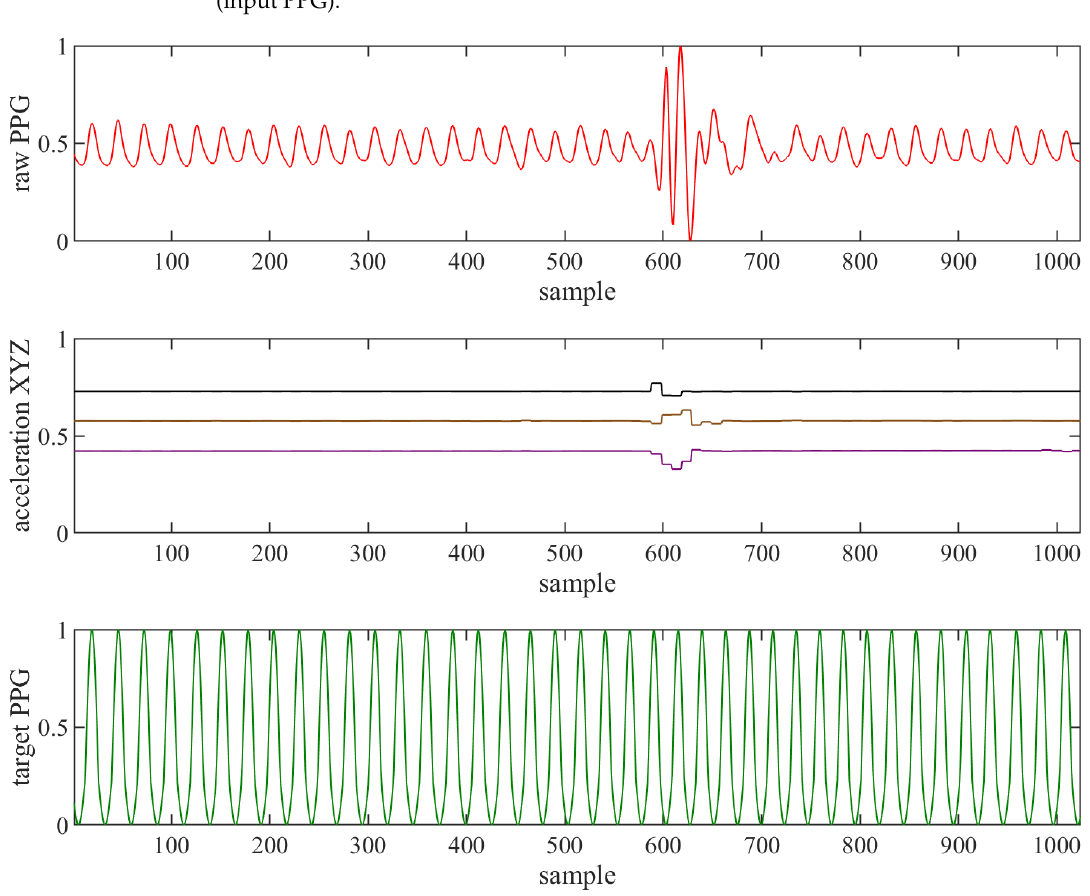
Figure 6. Normalised signals from PPG sensor (raw PPG) and accelerometer (acceleration XYZ) and manually generated target signal based on ideal sinus (target PPG).